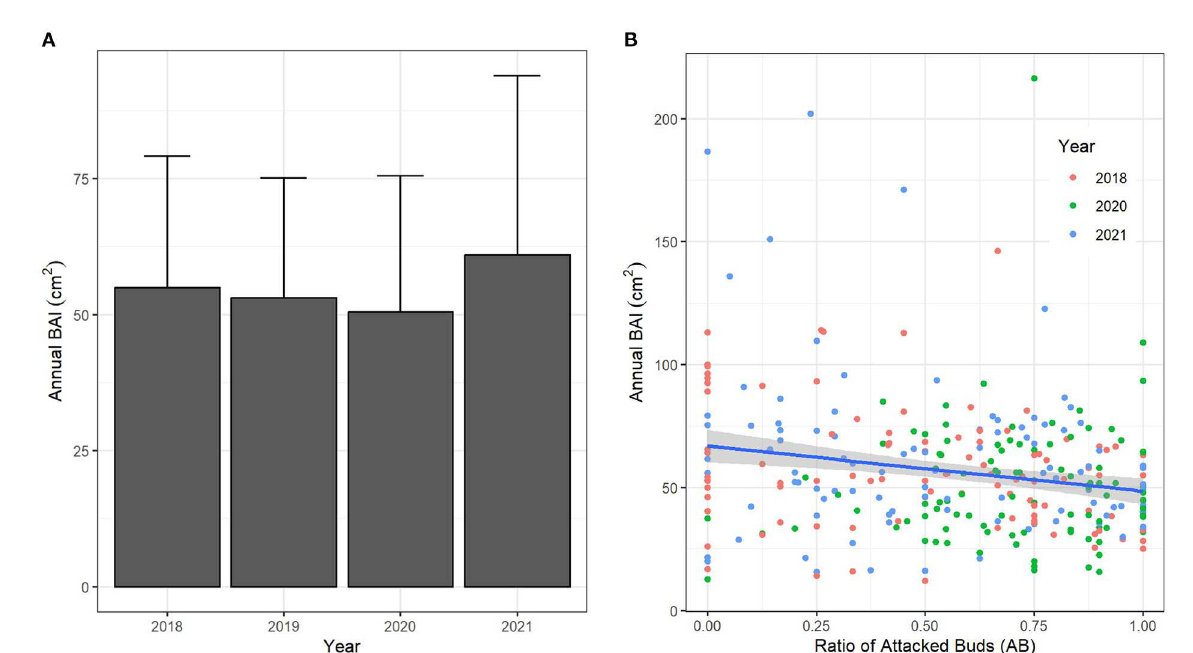
FIGURE4 (A) Bar plot with error bars (SE) for annual BAI for the 14 plots where C. sativa was present and trees had different levels of infestation. (B) Graphical relationship between the annual BAI and the ratio of attacked buds (AB) for each tree. The 95% confidence level interval for predictions from a linear model is indicated in